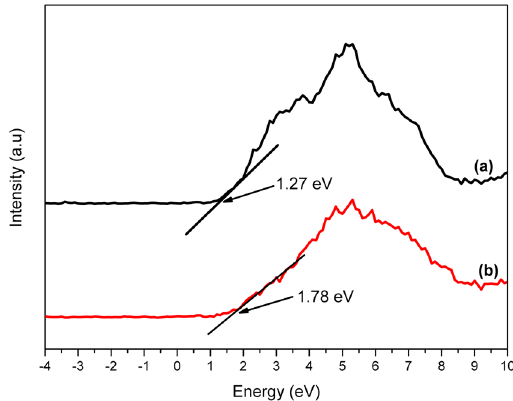
Figure 9. The VBs spectra of ( a ) BiVO 4 and ( b ) 3-2 Bi:Ti.